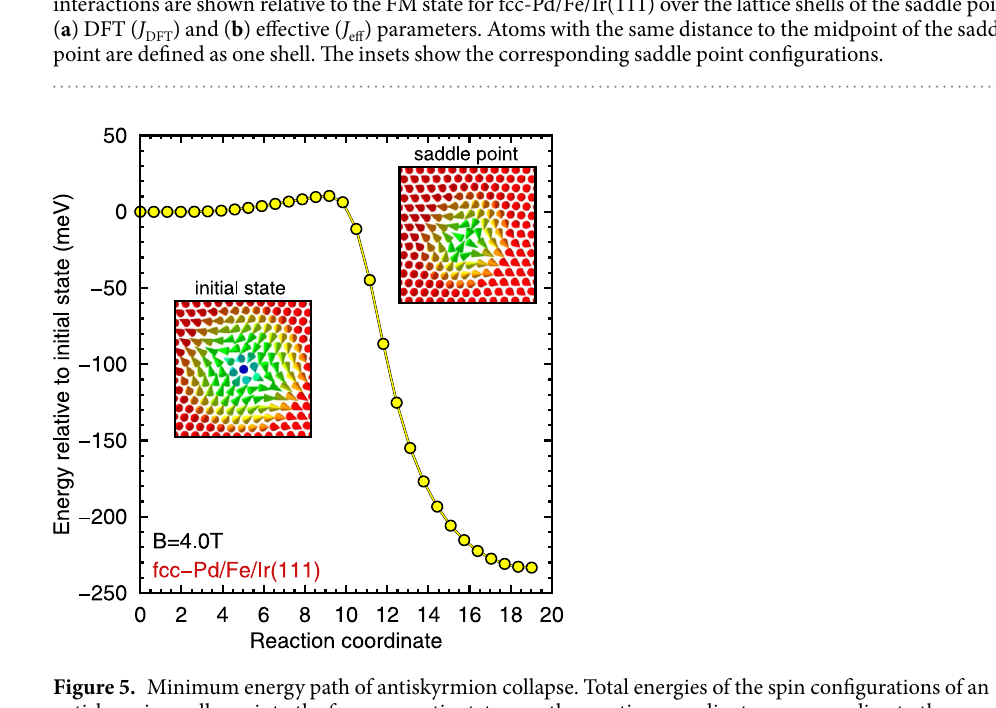
Figure 5. Minimum energy path of antiskyrmion collapse. Total energies of the spin configurations of an antiskyrmion collapse into the ferromagnetic state over the reaction coordinate corresponding to the progress of the collapse. The energies are given relative to the initial state, i.e. the isolated antiskyrmion. Insets show the isolated antiskyrmion and the saddle point configuration. In this simulation the full set of DFT parameters for fcc-Pd/Fe/Ir(111) were